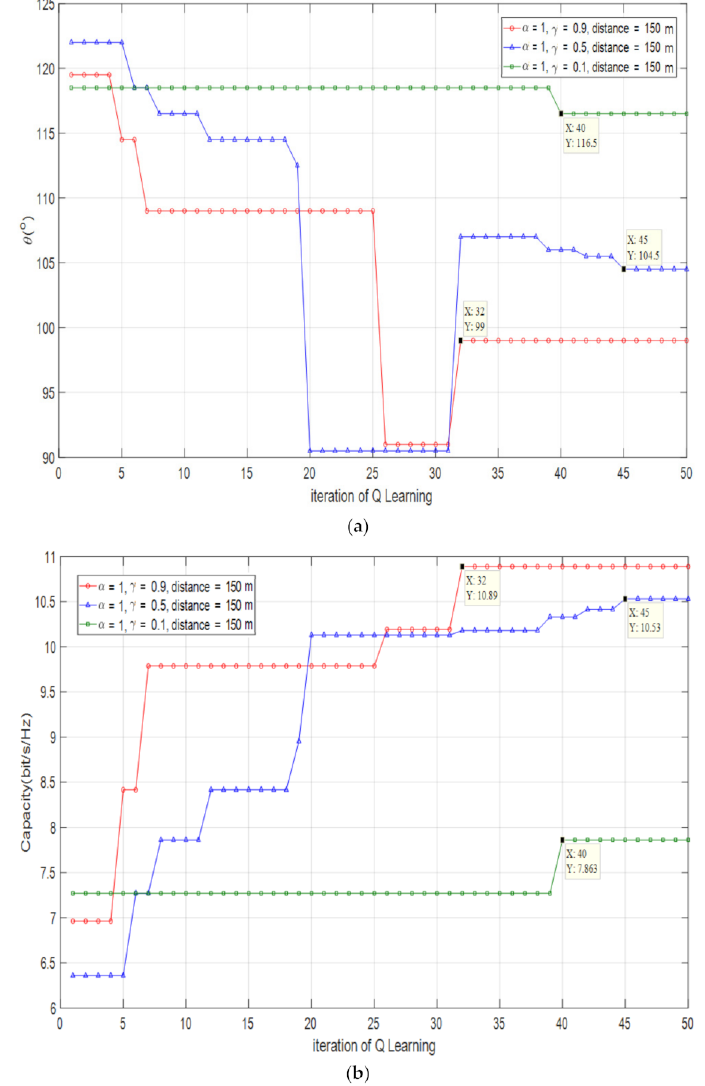
Figure 10. ( a ) Optimized antenna downtilt angle; ( b ) optimized channel capacity. D = 150 m, α = 1 with different γ